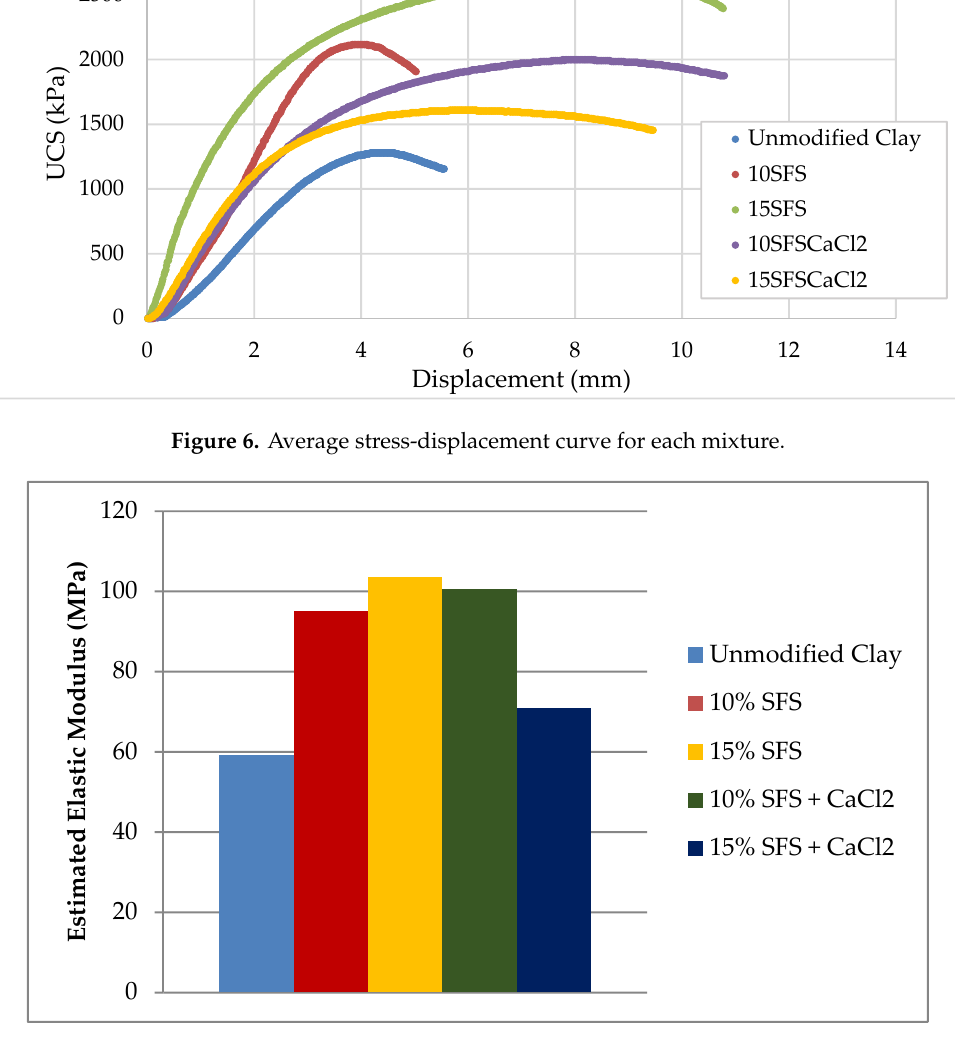
Figure 7. Average estimated elastic modulus for each mixture.